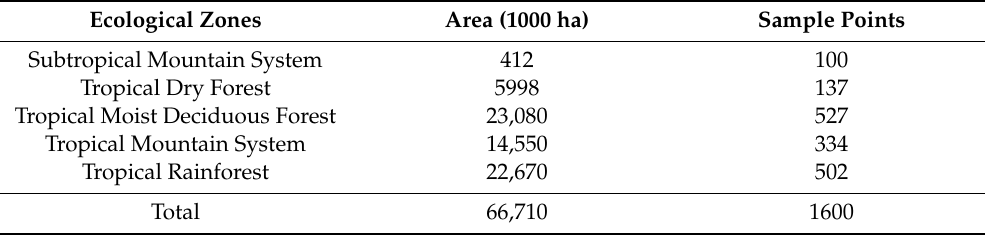
Table 1. Number of sample points for the five ecological zones.